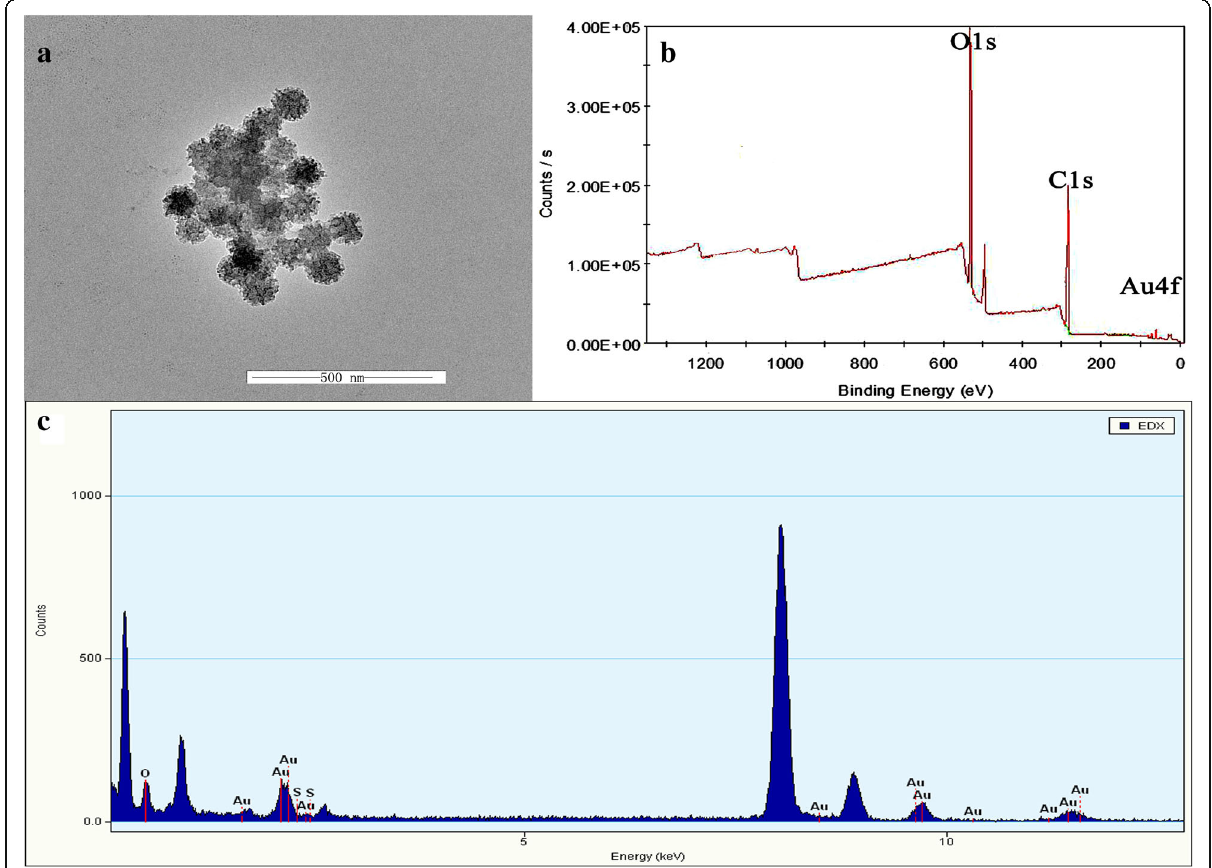
Fig. 1 Transmission electron micrographs of AuNS@PEG nanoparticles ( a ), XPS ( b ), and EDX ( c ) of the AuNS@PEG